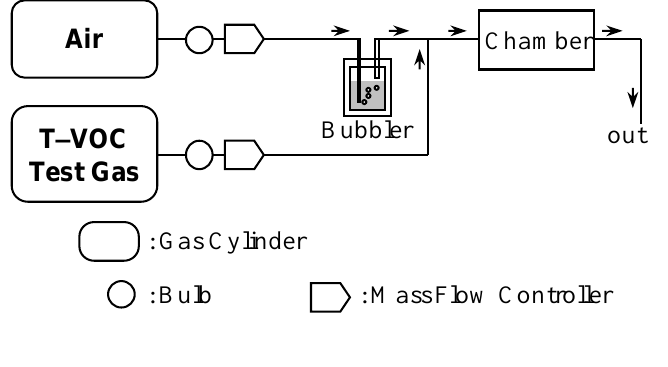
Figure 1. Schematic diagram of a flow-type gas sensing measurement